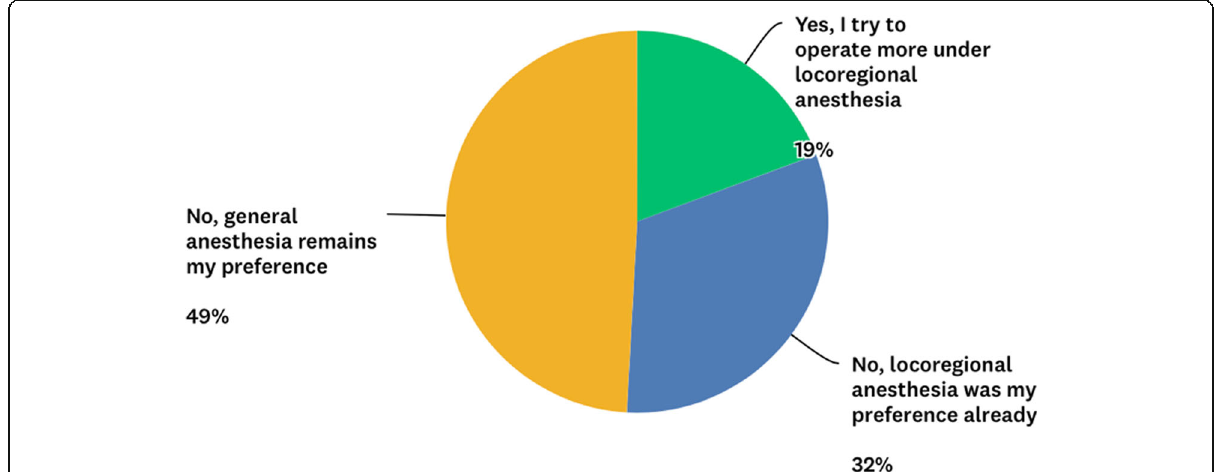
Fig. 5 Preference of type of anaesthesia (general vs locoregional anaesthesia) for elective care during the COVID-19